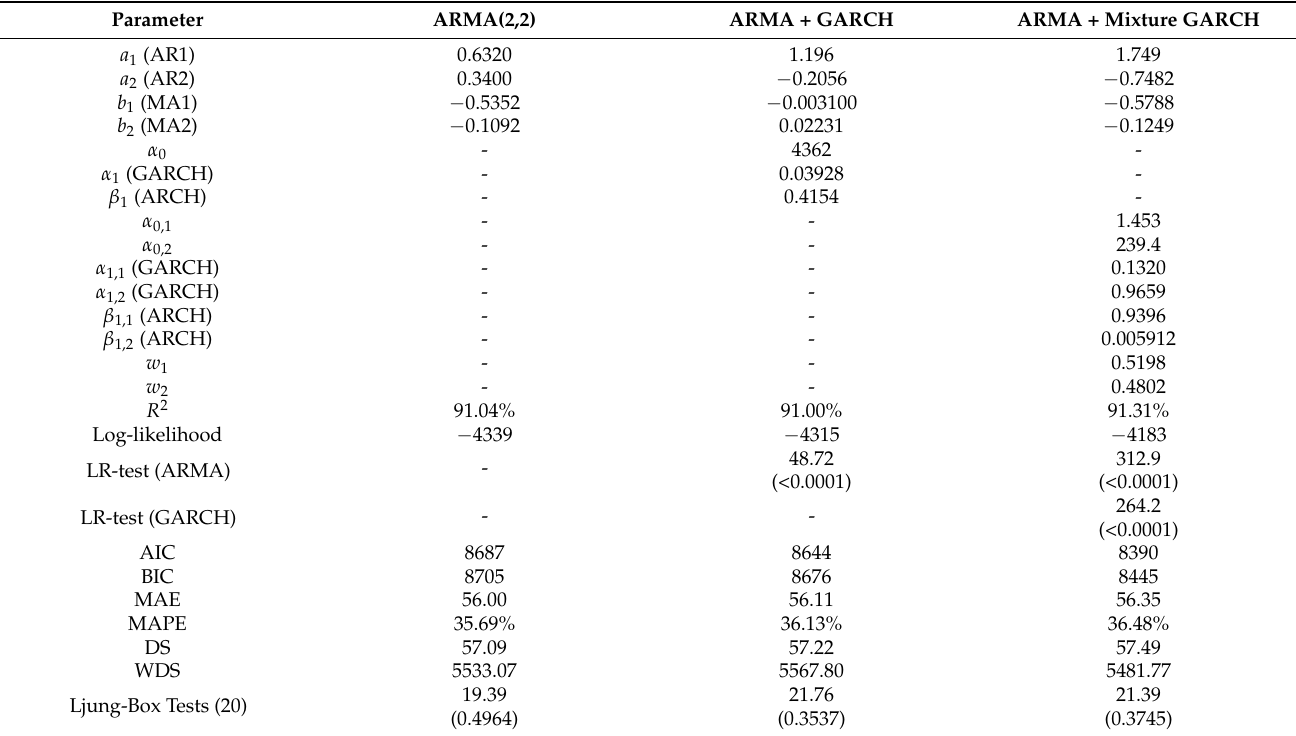
Table 5. Estimated parameters and performance measures for the second wind generation sample.